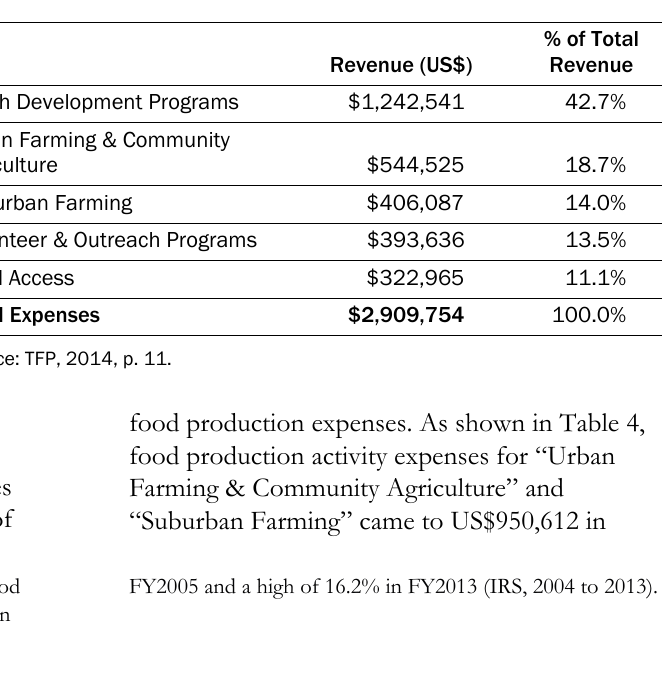
Table 4. The Food Project’s Expenses by Category (in